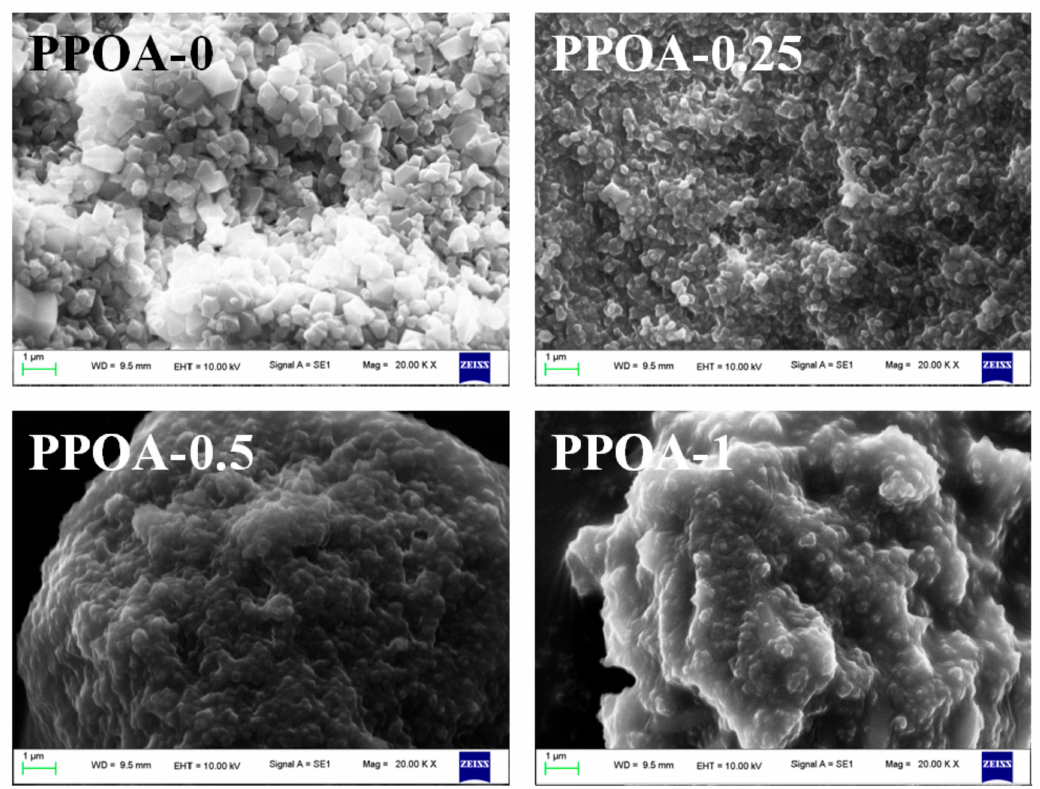
Figure 3. SEM images of PPOA-0, PPOA-0.25, PPOA-0.5, and PPOA-1; the scale bar is 1 µ